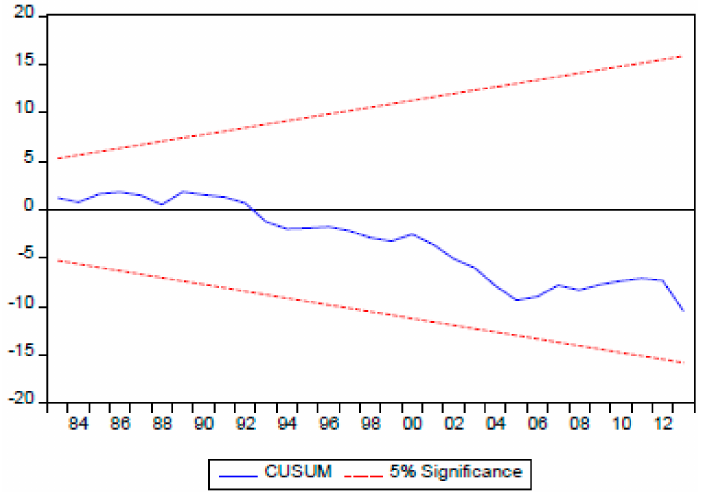
Figure 9. Plot of cumulative sum of recursive residuals for Turkey.